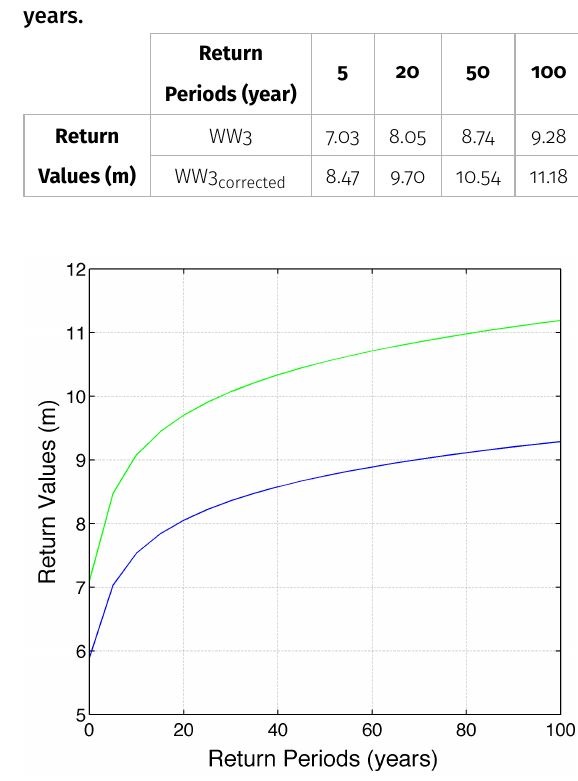
Figure 9. Return values (meters) versus return periods (years). The blue line represents the return values based only in the extreme data from WW3. The green line indicated the return values based on the extreme data from WW3 with bias